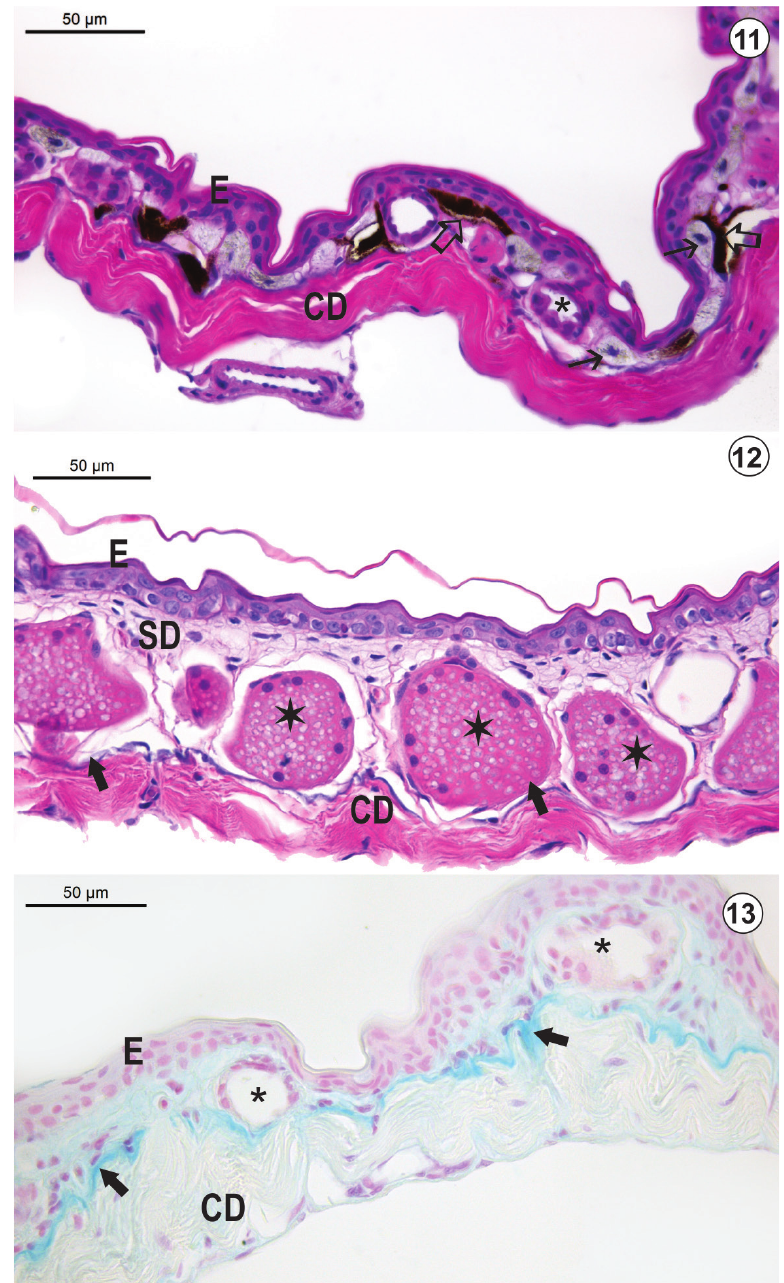
Figures 11–13. Light micrograph of the integument of O. albicans : (11) Dorsal region (HE-staining); (12) Ventrolateral region (HE-stain- ing); (13) Ventral region (AB-method). In all integument regions, the epidermis (E) rests on the dermis, which is subdivided into the spongious dermis (SD) and the compact dermis (CD). Iridophores ( → ) occur in the dorsal region; however, they are absent in both ventrolateral and ventral regions. Melanophores ( _ ) in the spongious dermis. Both serous ( Ø ) and apocrine glands ( ¬ ) occur in the spongious dermis. No glandular cell reacts to AB-method, suggesting that secretory units is made up of serous cells. The EK-layer ( Æ ) exhibits its typical basophilic staining. Note clusters of apocrine glands ( ¬ ) with heterogeneous content in the ventrolateral integument. The EK-layer (  ) exhibits typical alcianophilic reaction of its glycoconjugate content. Large blood vessels occur in